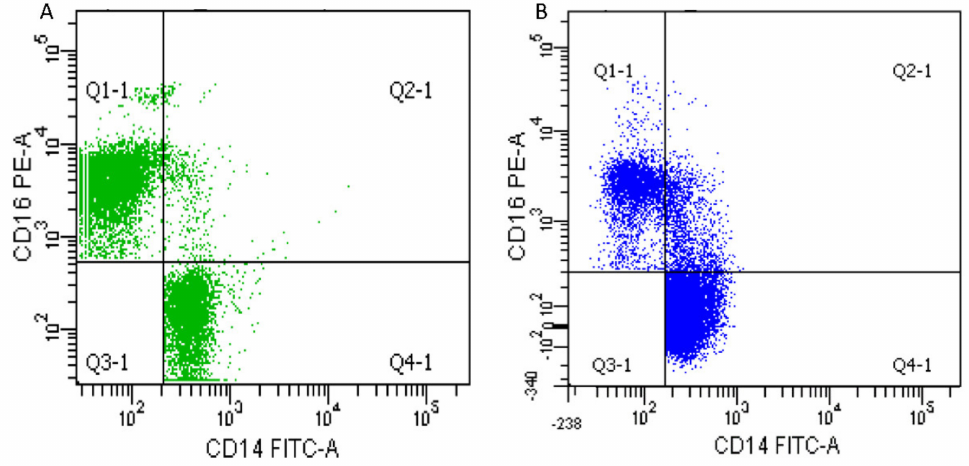
Figure 1. Representative scatter plots for CD14:FITC and CD16:PE were used to determine the per- centage of each phenotype by flux cytometry. Q4-1 contains the classical monocytes (CD14 ++ CD16 − ), Q2-1 contains the intermediate monocytes (CD14 ++ CD16 + ), and QI-1 contains the non-classical mono- cytes (CD14 + CD16 ++ ). ( A ) Typical scatter plot of a patient from the group 2 (1600 MET.min/sem– 4500 MET.min/sem); ( B ) Typical scatter plot from a patient from the group 3 (>4500